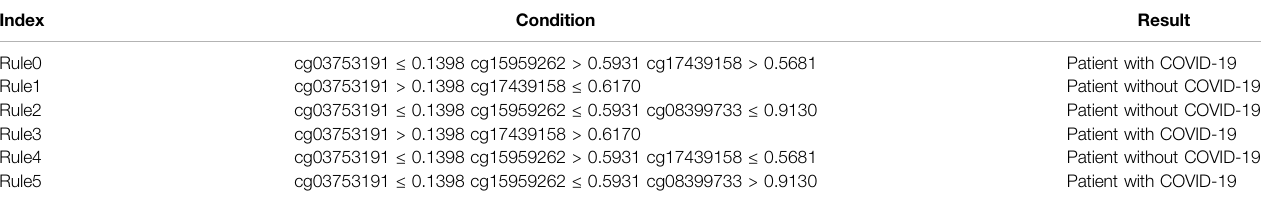
TABLE 1 | Rules yielded by decision tree on top 50